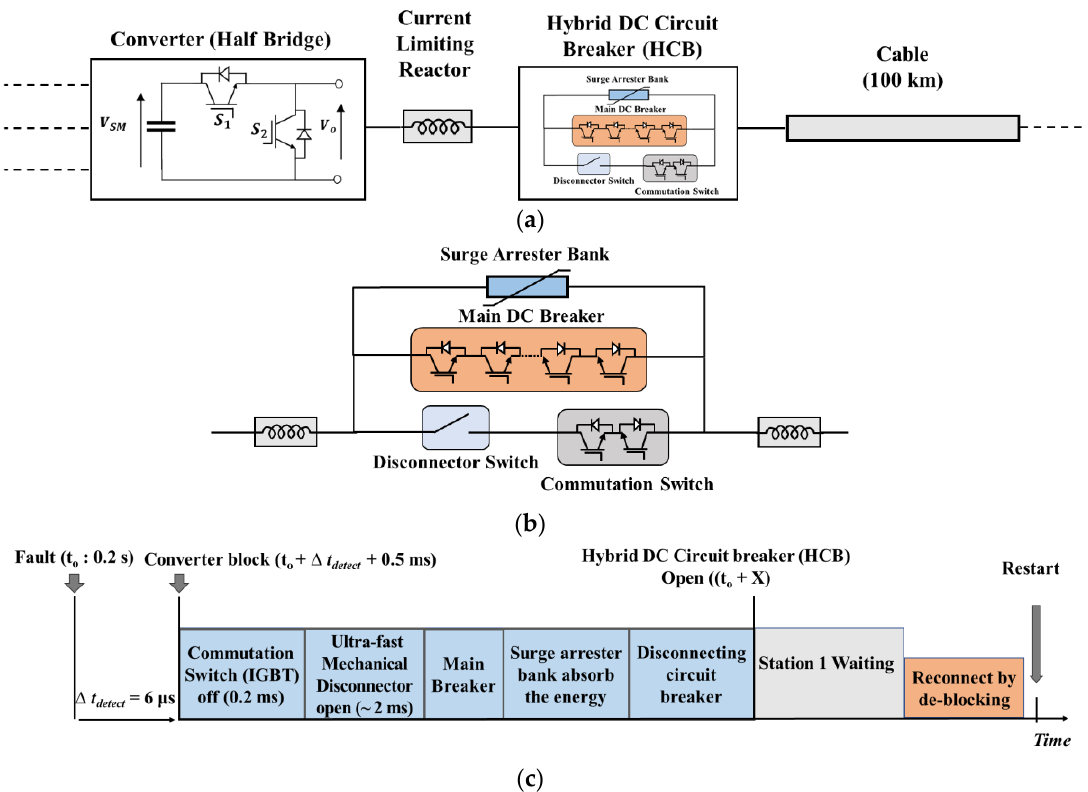
Figure 4. Case-1: DC fault handling solution for an HB-MMC based on a hybrid circuit breaker (HCB): ( a ) configuration of Case-1; ( b ) structure of the HCB; ( c ) fault handling under a DC short-circuit fault. Unlike AC circuit breakers (ACCBs), HVDC circuit breakers (CBs) must create a current zero